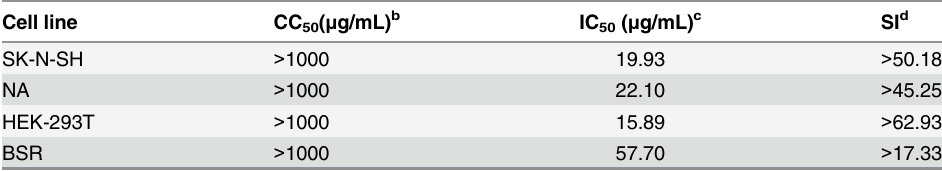
Table 2. Inhibitory effects of P32 on RABV replication in different cell lines. a